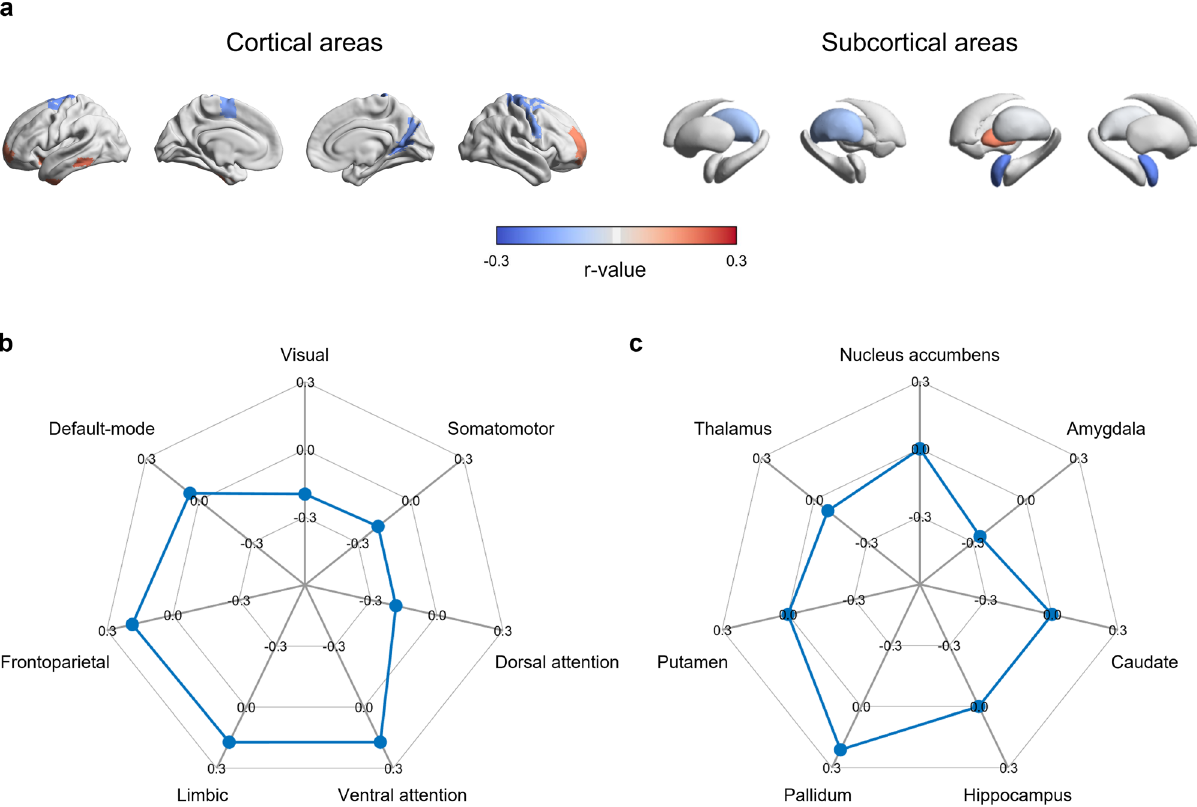
Fig. 2 Brain regions associated with obesity phenotype. a Correlation coef fi cient of the identi fi ed regions that showed signi fi cant association with waist- to-hip ratio (WHR) are reported on brain surfaces and subcortical structures using 301 participants. Red/blue indicate positive/negative correlations. The correlation coef fi cients are strati fi ed based on b functional communities as well as c subcortical